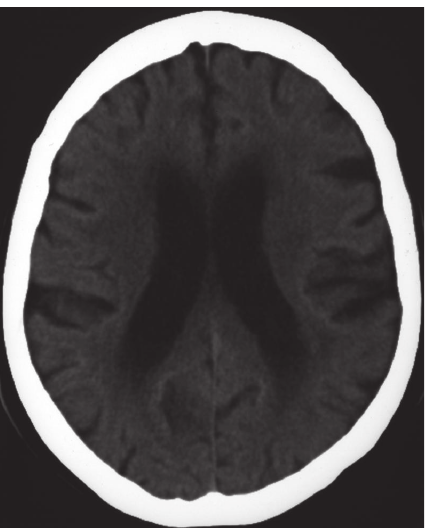
Figure1:BrainCT-scanperformedduringfollow-upin2008,show- ing periventricular white matter damage (left-right was inverted as radiological